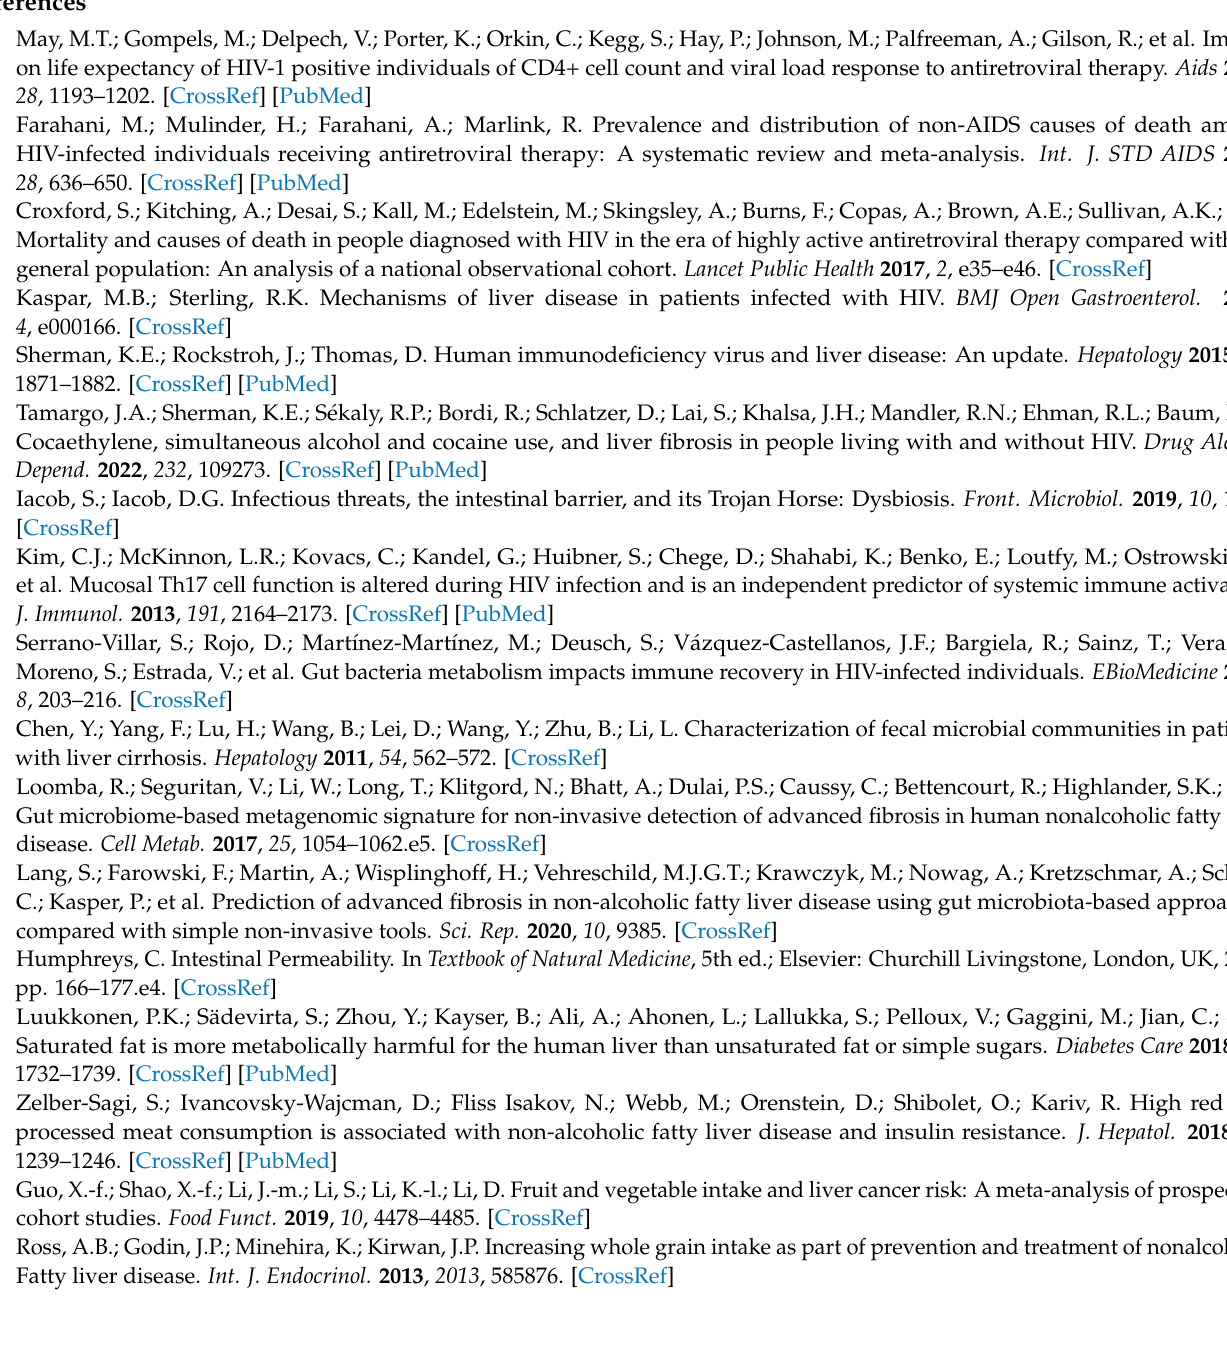
between those with and without FIB-4 ≥ 1.45. The X-axis shows the difference in means of the concentrations of the metabolites after the variance-stabilizing normalization, while the Y-axis shows a negative log of p-value determined by Wilcoxon rank-sum tests without false discovery rate ( left plot ) and with Benjamini–Hochberg p -value correction ( right plot ). Blue points (upper right) show metabolites that have significantly higher concentrations in the cohort with FIB-4 ≥ 1.45 (dm > 0.5, p -value < 0.05), while green points (upper left) show metabolites that have significantly higher concentrations in the group with FIB-4 < 1.45 (dm < − 0.05, p -value < 0.05). The two vertical dotted lines represent the two thresholds showing dm >0.5, while the dotted horizontal line represents a p-value threshold of 0.05 (i.e., negative log p -value of 1.3). FIB-4 score ≥ 1.45 was defined as “unable to exclude advanced liver fibrosis/cirrhosis”. Abbreviation: FIB-4, Fibrosis-4